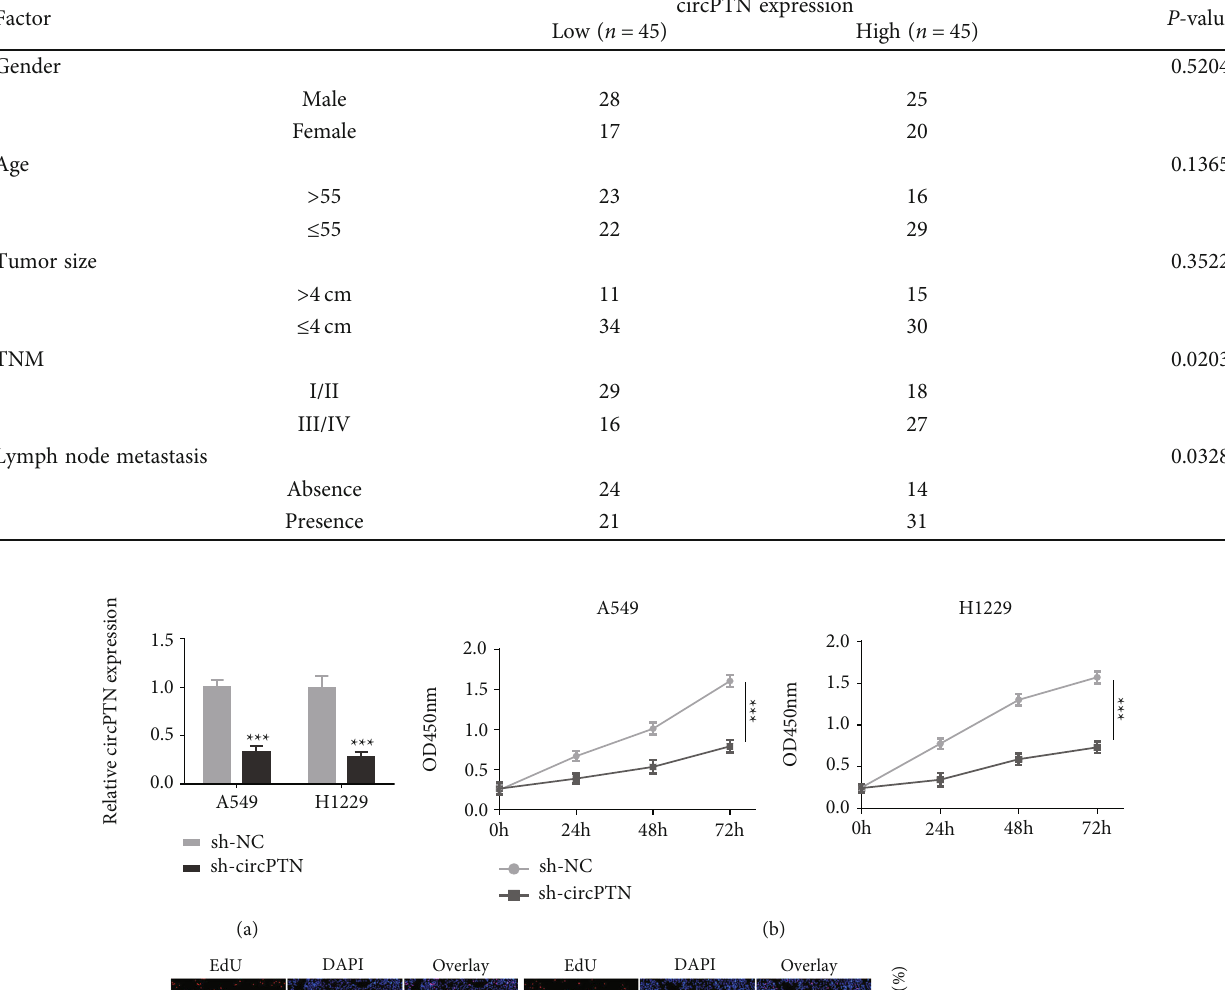
Table 1: Correlations of circPTN expression level with clinicopathologic features of NSCLC patients.